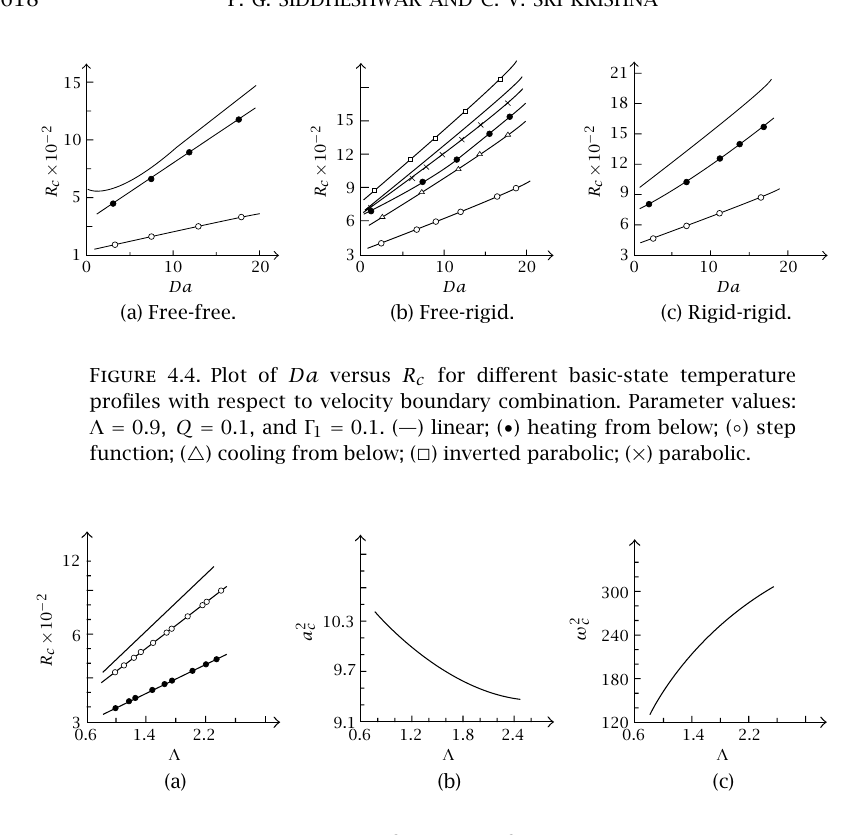
Figure 4.5 . Plot of (a) R c , (b) a 2 c , and (c) ω 2 c versus Λ for different basic- state temperature profiles with respect to the free-free velocity boundary combination. Parameter values: Γ 1 = 0 . 1 , Q = 0 . 1 , Da = 5 . 0. (—) linear; ( ◦ ) heating from below; ( • ) step